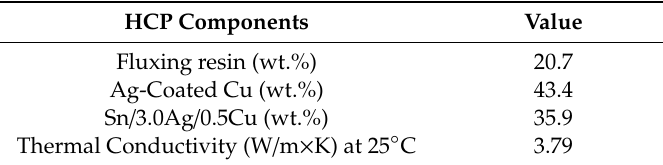
Table 1. Composition of components and thermal conductivity of cured Hybrid Cu paste (HCP) used.